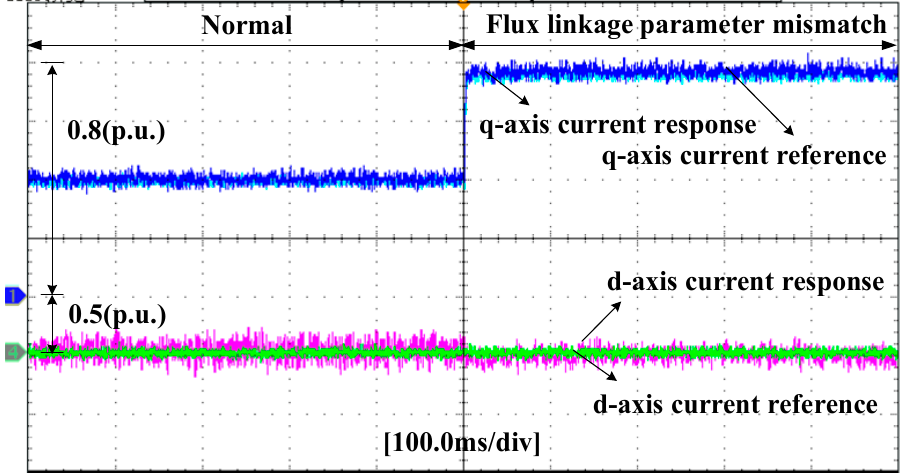
Figure 14. Experimental results of the RNPCC method under flux linkage parameter perturbation.